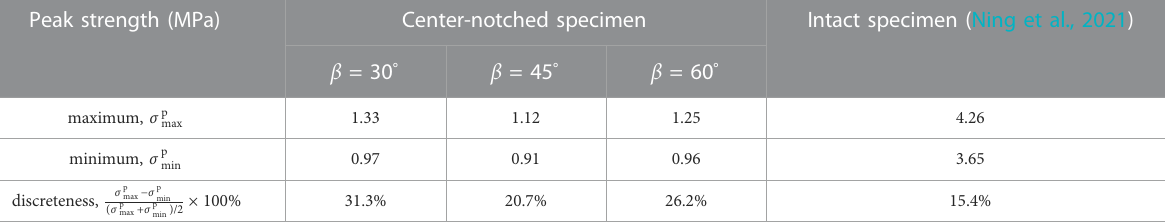
TABLE 1 Peak strength discreteness of disc specimens ( m = 5). Peak strength